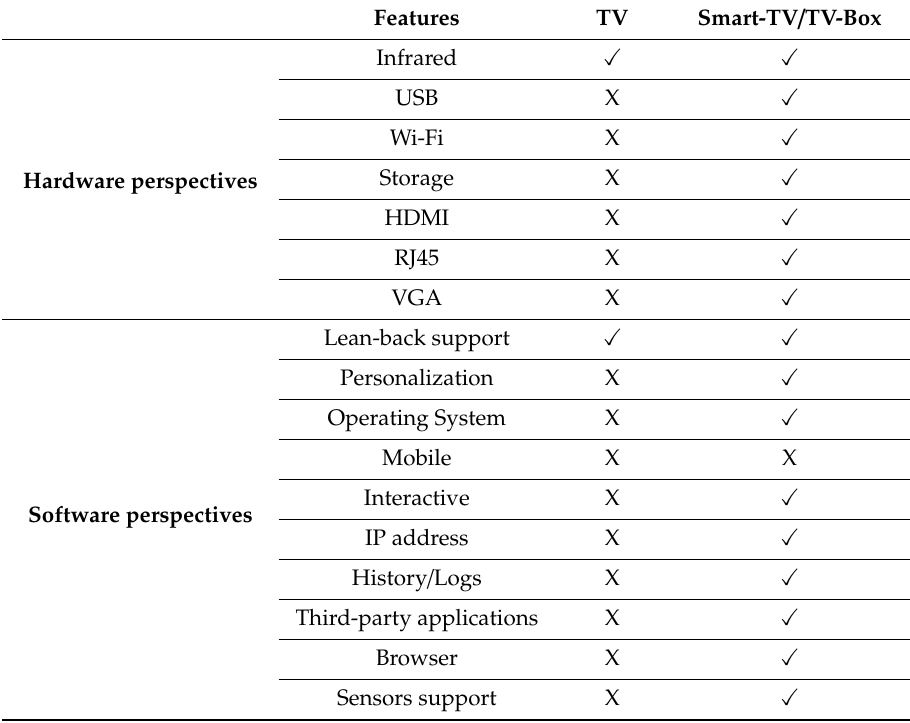
Table 1. A comparison of smart TV features with the legacy TV